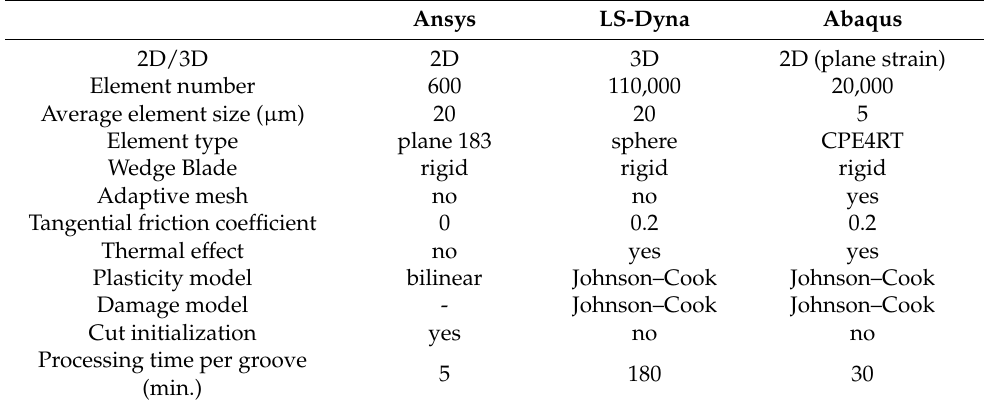
Table 4. FE models summary. Processing time is on 2.6 GHz 64-bit processor with 8 GB RAM PC.